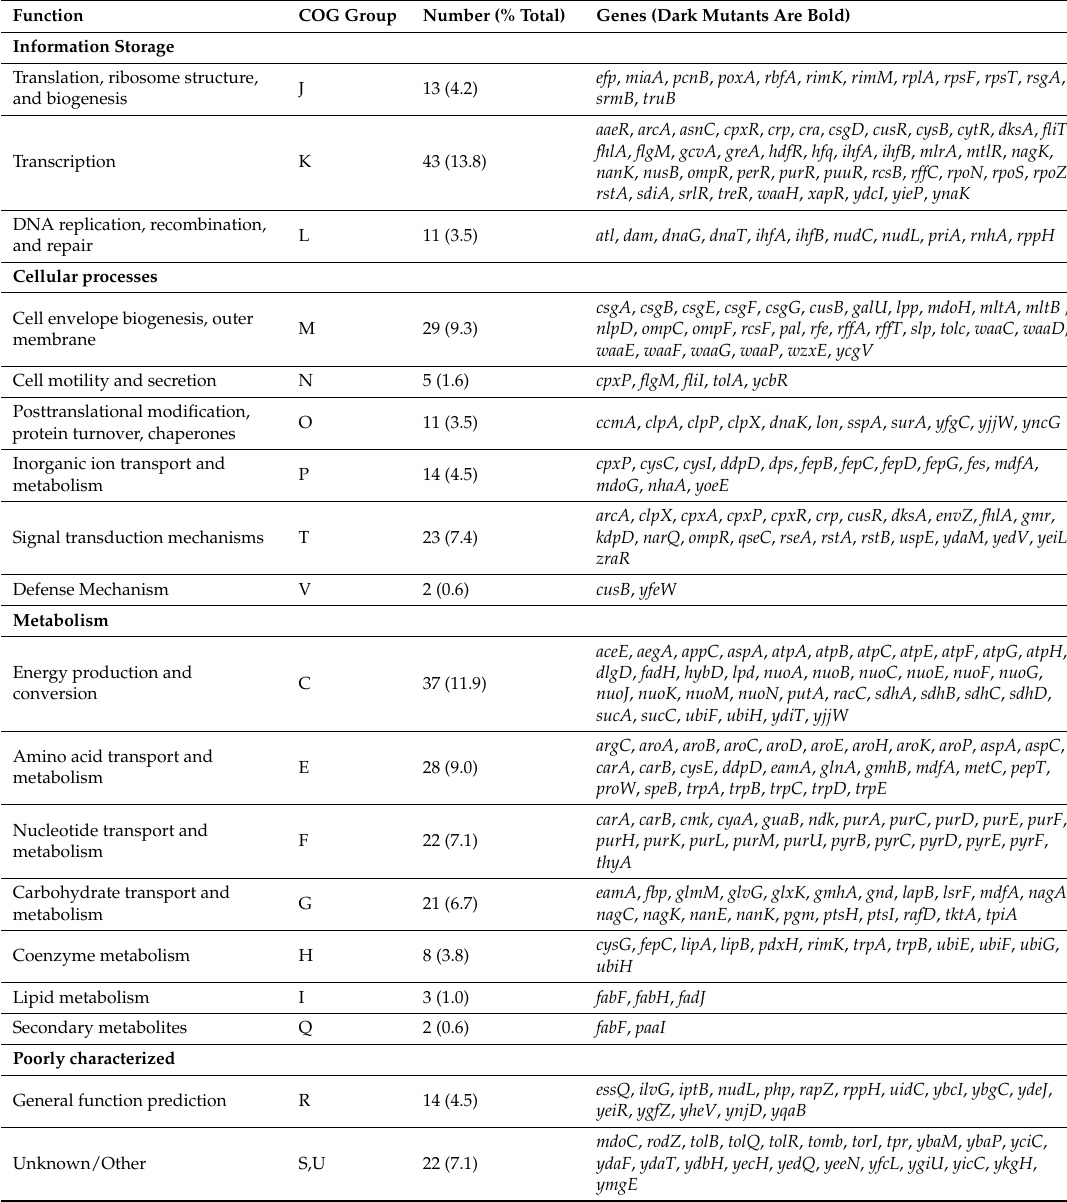
Table 1. Primary cellular role of genes that affect curli